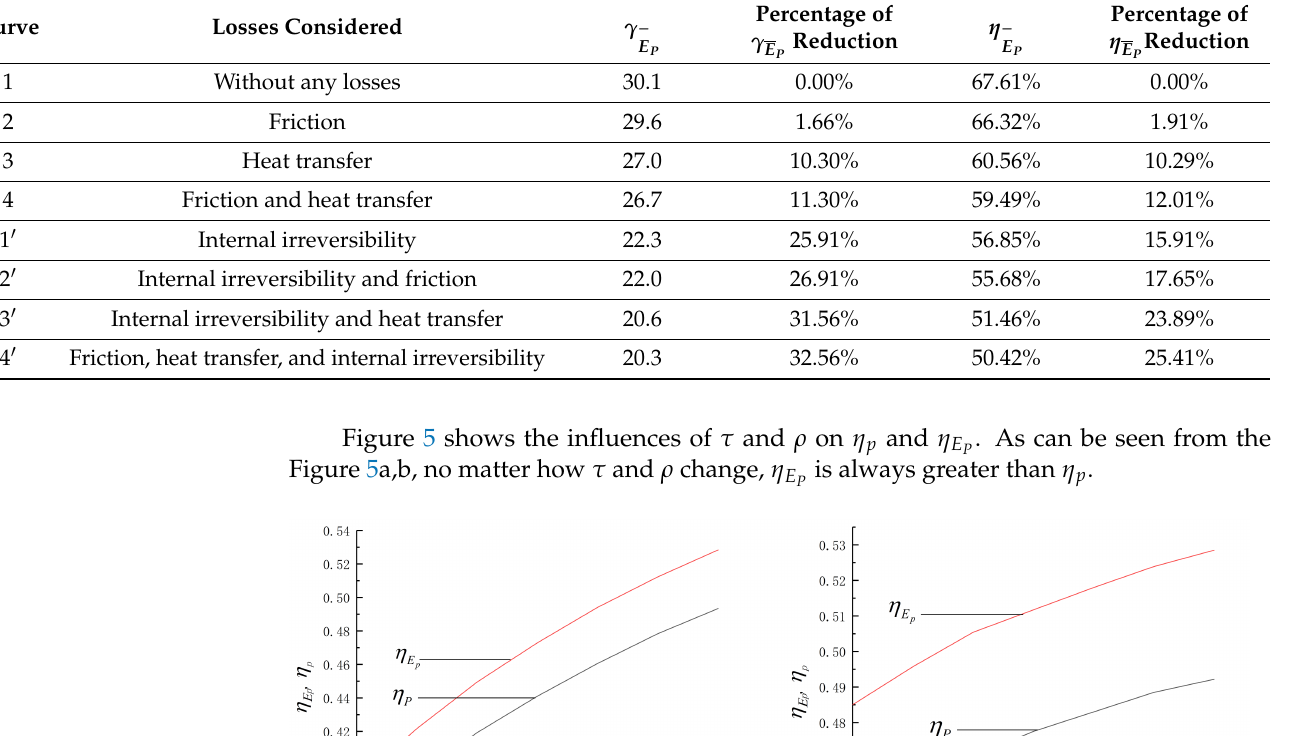
Table 1. Comparison of the γ